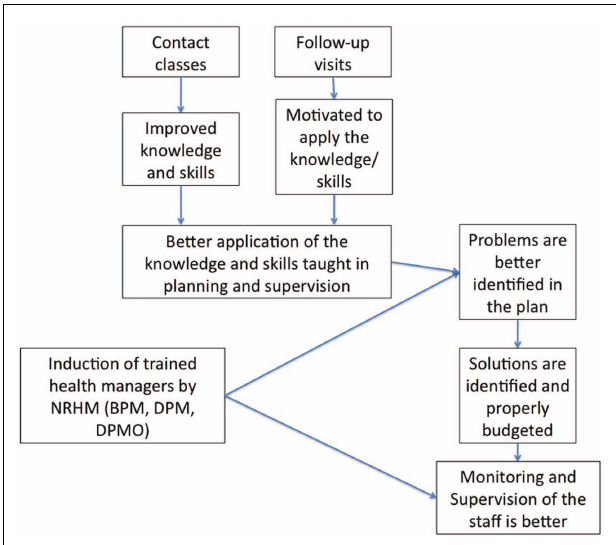
FIGURE 2 |The initial program theory of the intervention as conceived by the program designers . Reproduced from the study protocol